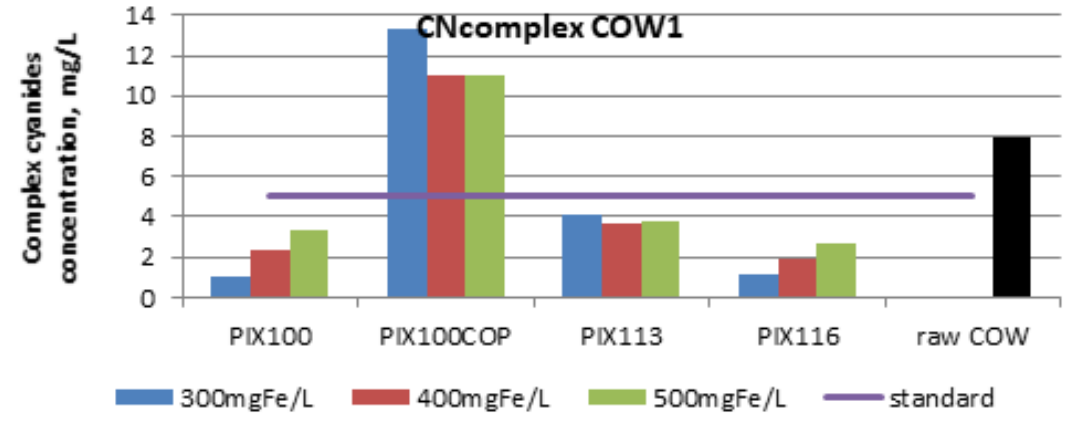
Figure 7: Final concentration of complex cyanides in COW1.